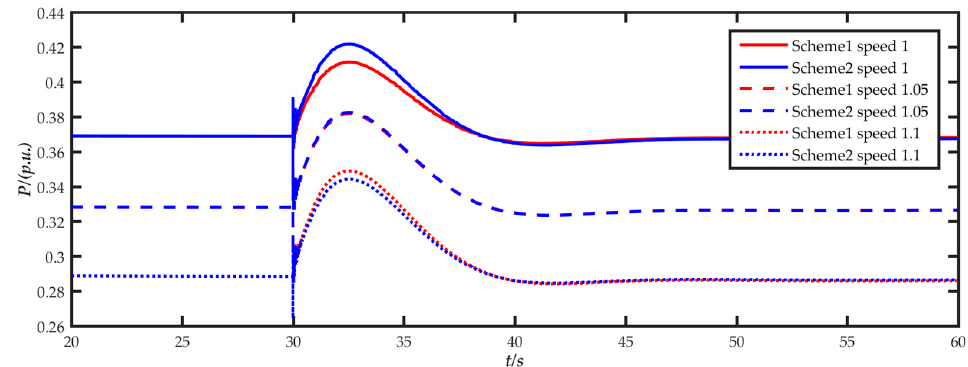
Figure 14. Power change in wind turbines in the high-wind speed zone.